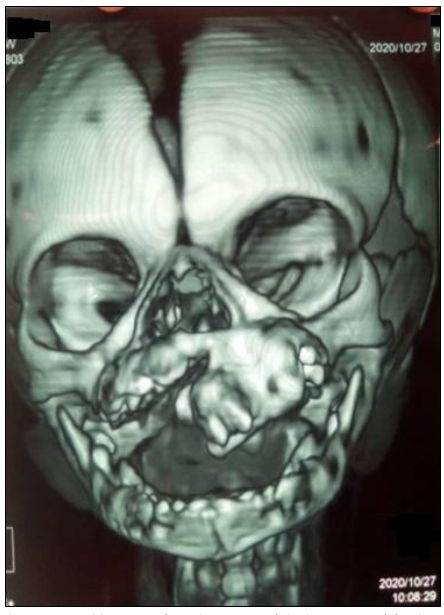
Figure 2: CT scan showing a multi-tissue oral lesion suggestive of a teratoma.